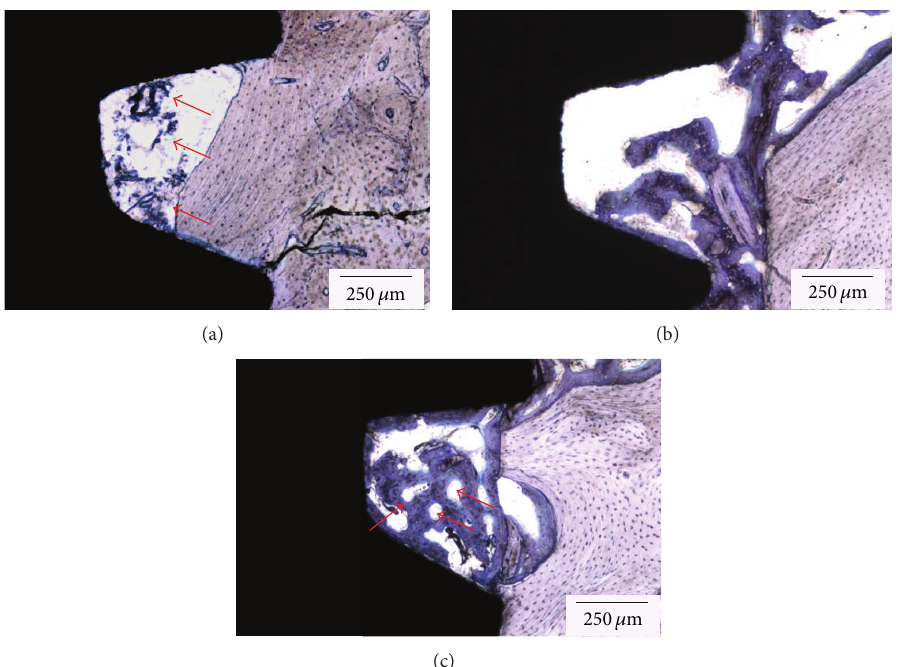
Figure 4: Histologic evaluation showed that at (a) 1 week, initial woven bone formation occurred in the regions between threads and in direct contact with the implant surface (arrows). (b) At three weeks, an increase in the amounts of bone between threads was evident, and the (c) onset of replacement of woven bone by lamellar bone was observed for all groups evaluated at 5 weeks